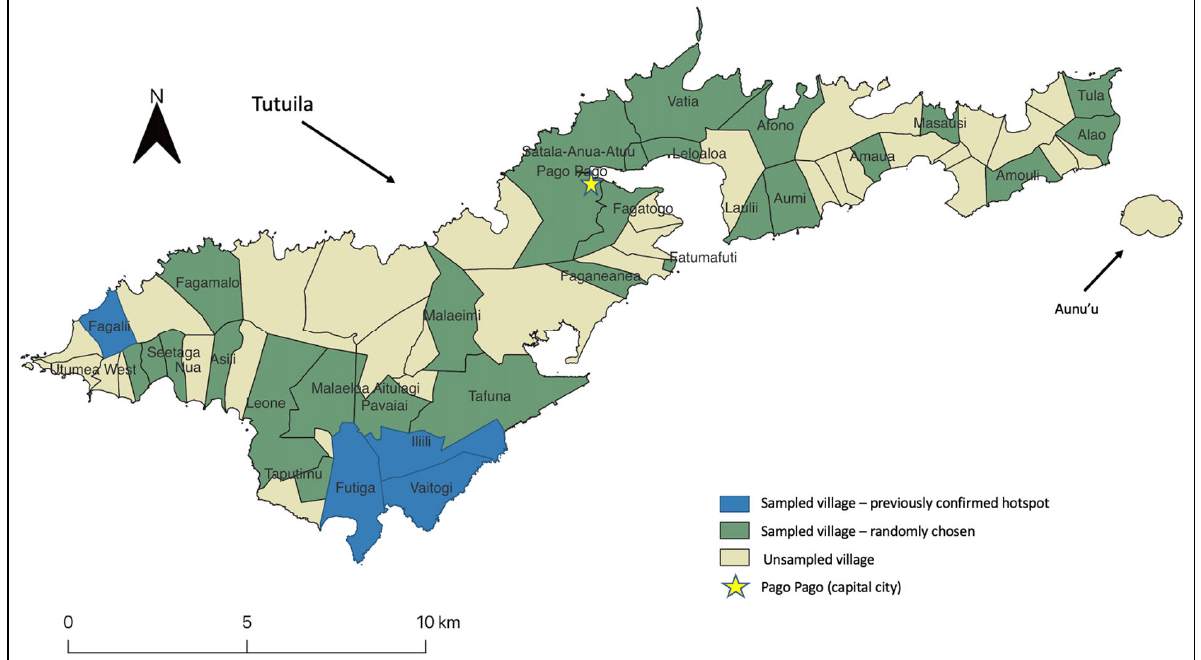
Figure 1. Map displaying administrative village borders on the two largest islands of American Samoa, Tutuila and Aunu’u. The locations of the villages sampled in the 2016 community survey are indicated on the map. Topographic base layer sourced from ESRI [37].